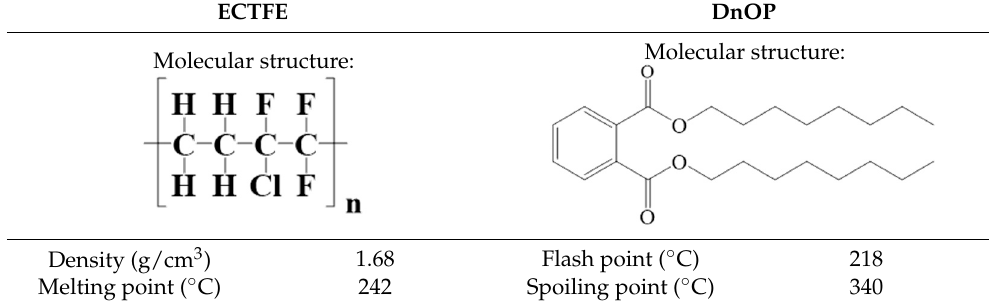
Table 2. The basic properties of ECTFE and DnOP. ECTFE Molecular structure: